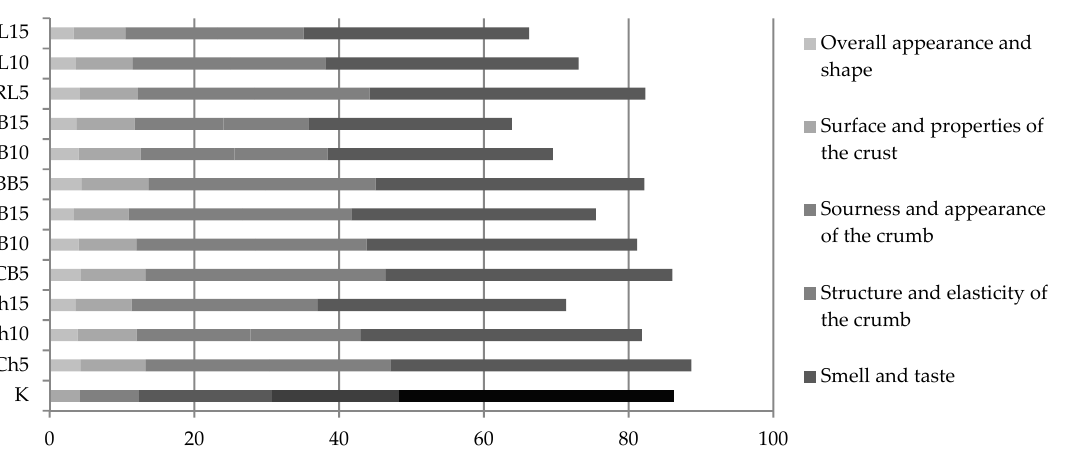
Figure 10. Sensory evaluation of the trial breads by means of a 100-point system. K = WF(50) + RF(50); Ch5 = WF(50) + RF(45) + ChF(5); Ch10 = WF(50) + RF(40) + ChF(10); Ch15 = WF(50) + RF(35) + ChF(15); CB5 = WF(50) + RF(45) + CBF(5); CB10 = WF(50) + RF(40) + CBF(10); CB15 = WF(50) + RF(35) + CBF(15); BB5 = WF(50) + RF(45) + BBF(5); BB10 = WF(50) + RF(40) + BBF(10); BB15 = WF(50) + RF(35) + BBF(15); RL5 = WF(50) + RF(45) + RLF(5); RL10 = WF(50) + RF(40) + RLF(10); RL15 = WF(50) + RF(35) + RLF(15).